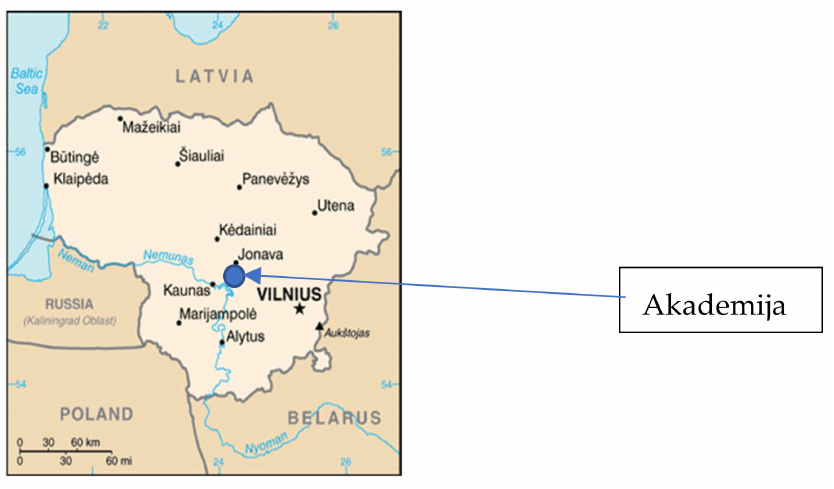
Figure 3. Geographical location of